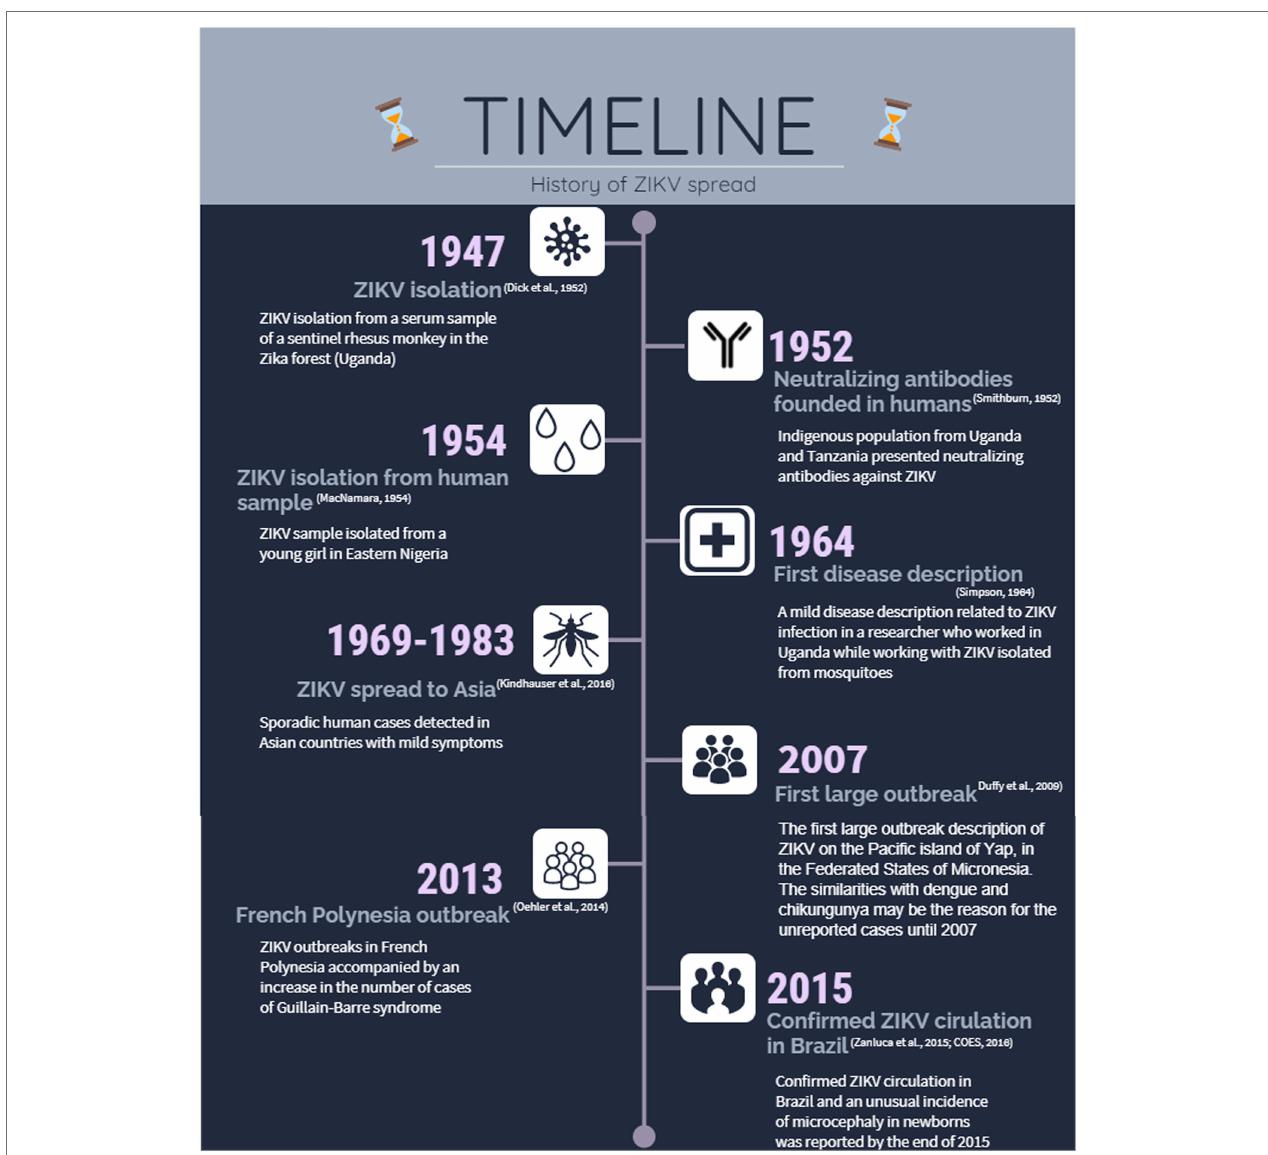
FIGURE 1 | Zika virus (ZIKV) spread since its isolation until the outbreak in Brazil in 2015. Representative timeline infographic highlighting the main events related to the spread of